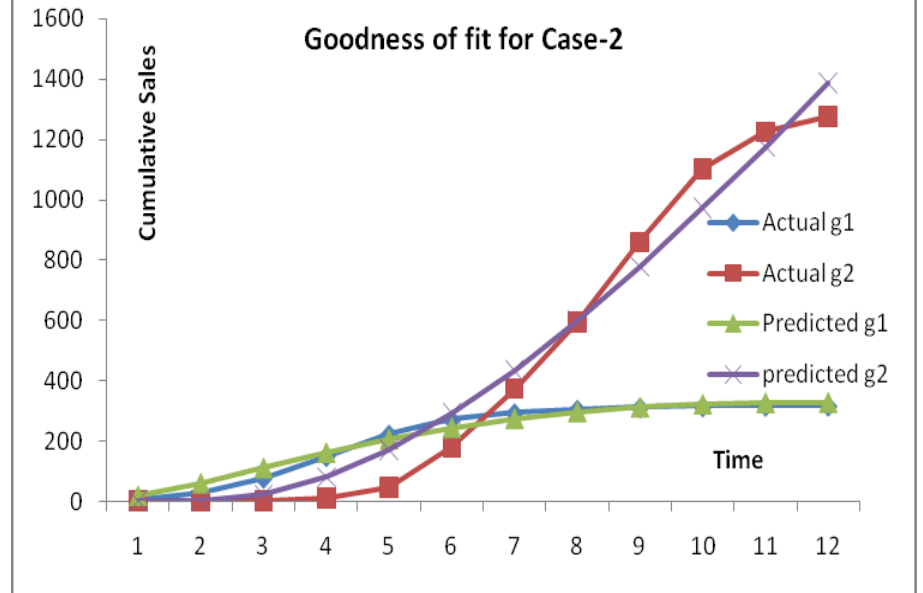
Fig. 2. Goodness of fit curve for case-2